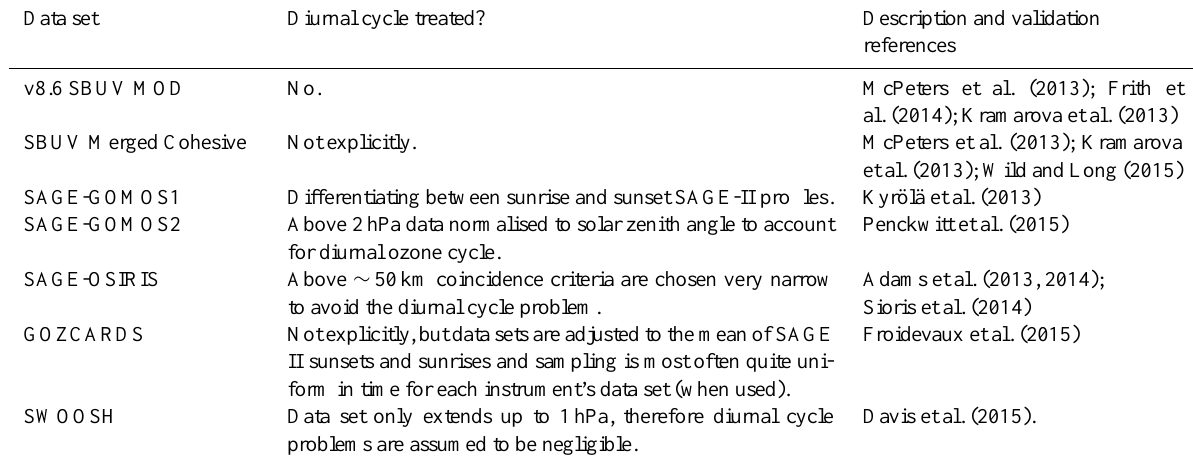
Table 6. Summary of the treatments of the diurnal cycle and references for each of the seven data sets. Data set